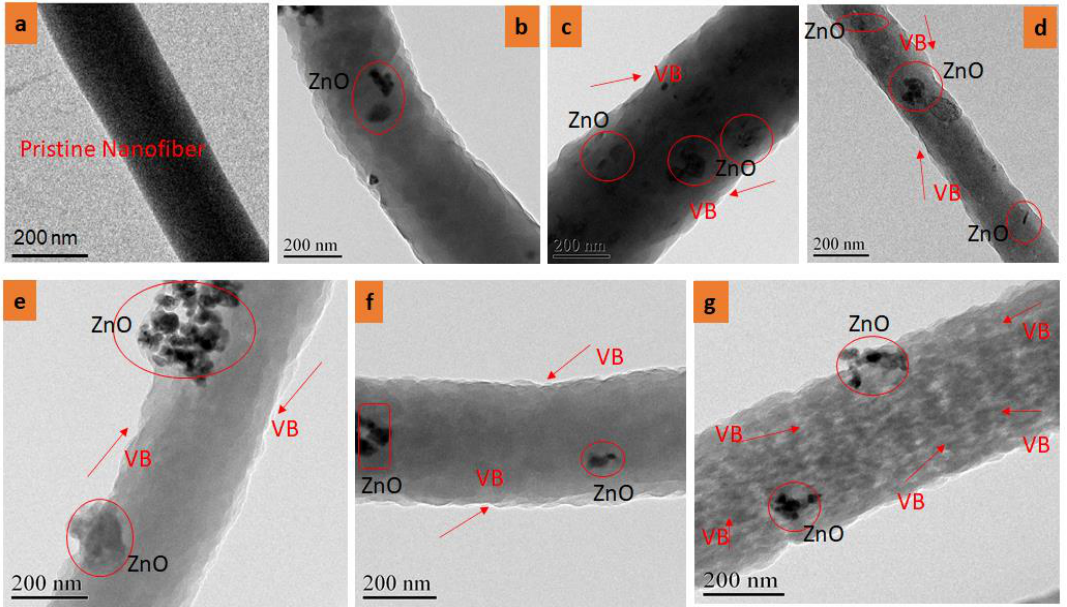
Figure 4. TEM analysis of Prepared VB-loaded ZnO/PAN electrospun nanofibers: ( a ) pristine PAN electrospun nanofibers; ( b ) ZnO/PAN electrospun nanofibers; ( c ) 0.5% VB-loaded ZnO/PAN electrospun nanofibers; ( d ) 1.5% VB-loaded ZnO/PAN electrospun nanofibers; ( e ) 2.5% VB-loaded ZnO/PAN electrospun nanofibers; ( f ) 3.5% VB-loaded ZnO/PAN electrospun nanofibers; ( g ) 5% VB-loaded ZnO/PAN electrospun nanofibers.